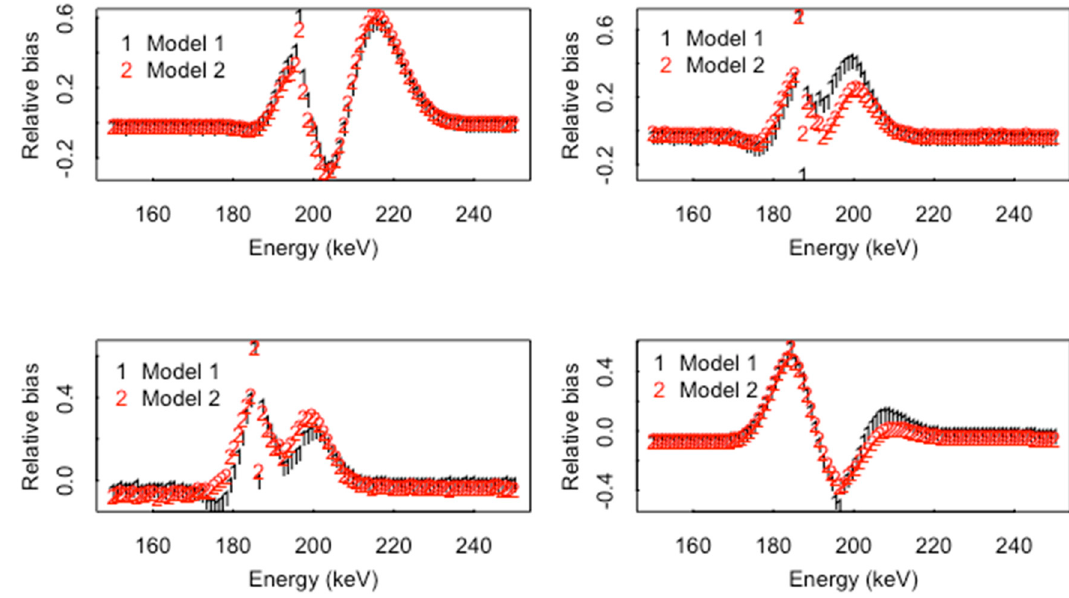
Figure 6. The relative bias in model 1 and model 2.